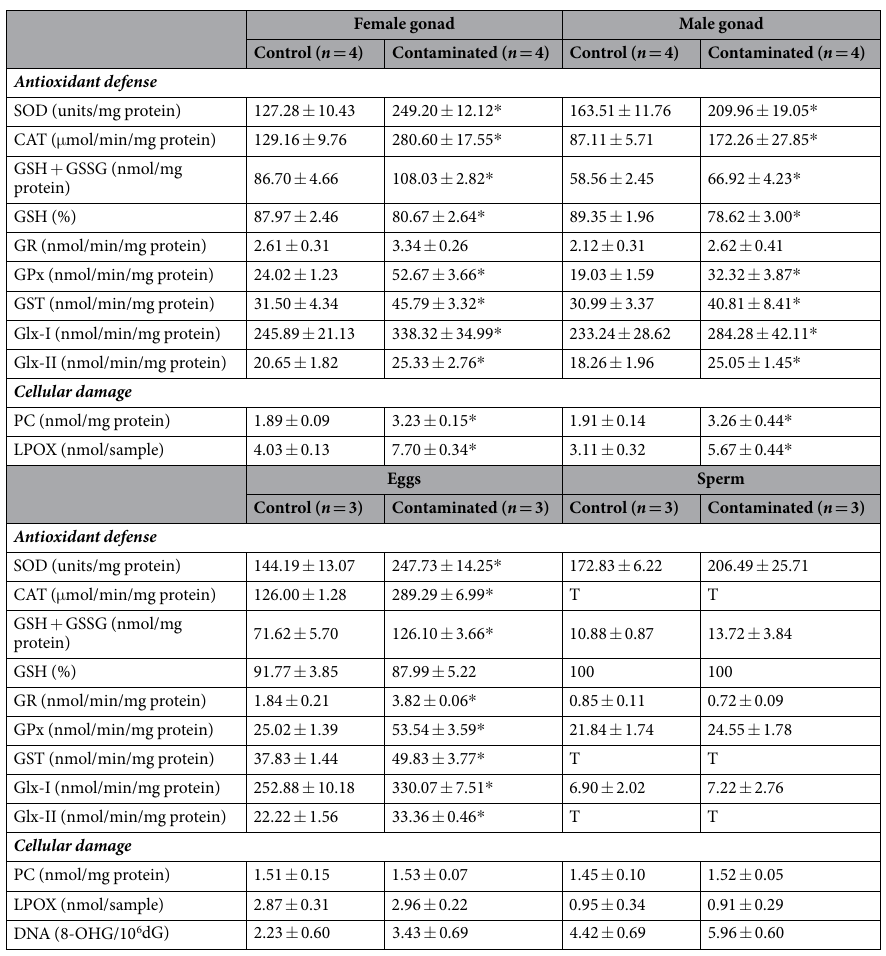
Table 1. Mean ± SE activities of superoxide dismutase (SOD), catalase (CAT), glutathione reductase (GR), glutathione peroxidase (GPx), glyoxalase-I (Glx-I), glyoxalase-II (Glx-II), glutathione-S-transferase (GST), total glutathione (GSH + GSSG), reduced glutathione (GSH), and levels of protein carbonyls (PCs), lipid hydroperoxides (LPOX) and 8-hydroxydeoxyguanosine (8-OHdG), in the gametes and gonad tissue of male and female Evechinus chloroticus fed PAH-contaminated versus control Ulva pertusa . N = 3. An * indicates a significant difference to the control ( P < 0.05). T = trace levels